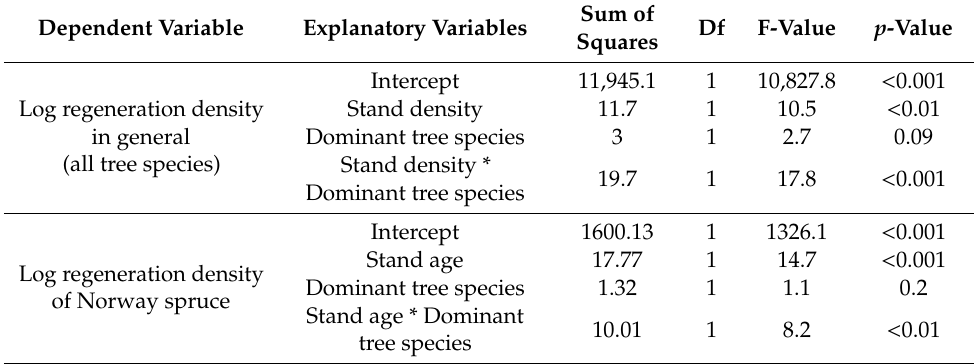
Table 2. Parameter estimates of the best (by AIC) fitted linear models. (Df): degree of freedom, *—interaction between